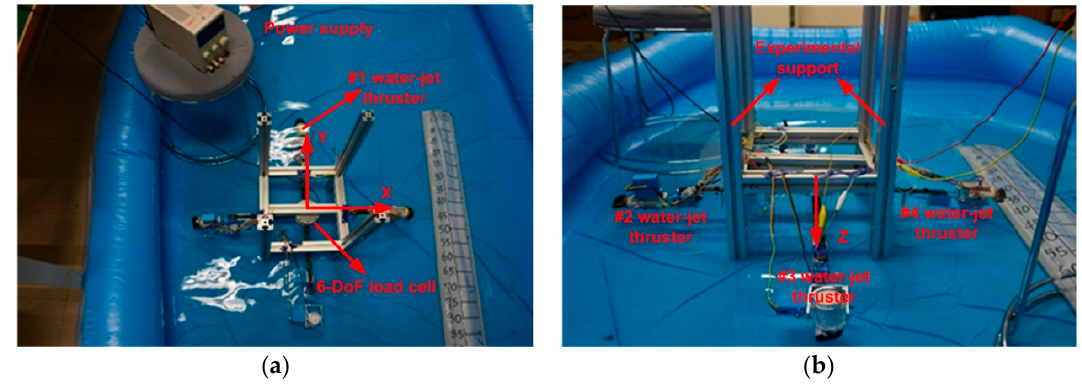
Figure 18. The experimental setup. ( a ) Top view; ( b ) Side view.